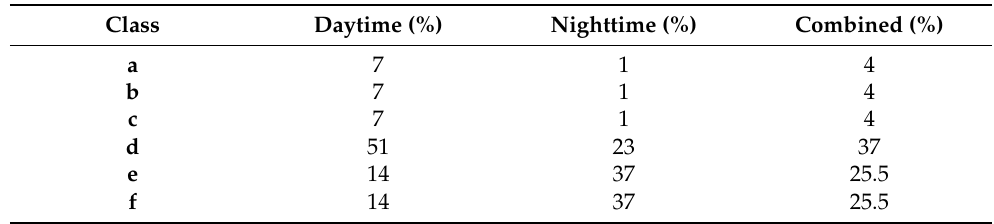
Table 2. Average frequencies of occurrence P ( i ) of atmospheric stability class i in the Northern Hemisphere. The data is collected from [56].